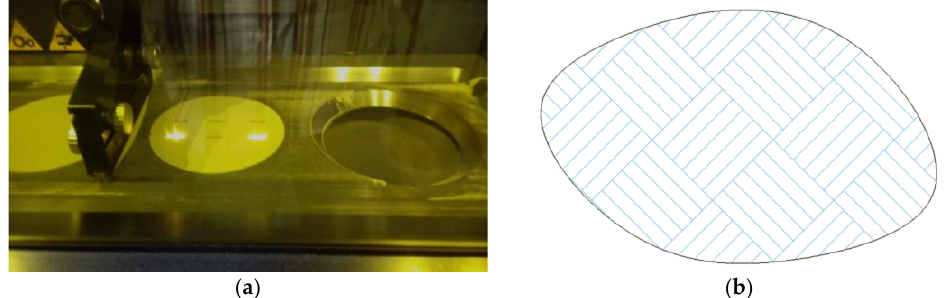
Figure 2. ( a ) Sisma equipment used to manufacture the specimens (dual laser technology); ( b ) island laser scanning applied on a slice.